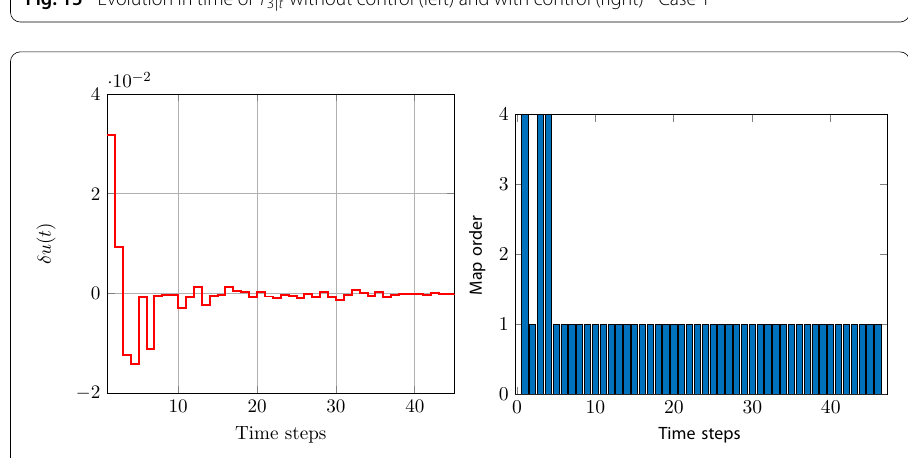
Fig. 16 Evolution of the command variable in terms of incremental corrections (left), and map order required at each assimilation time step in the case of system control (right) - Case